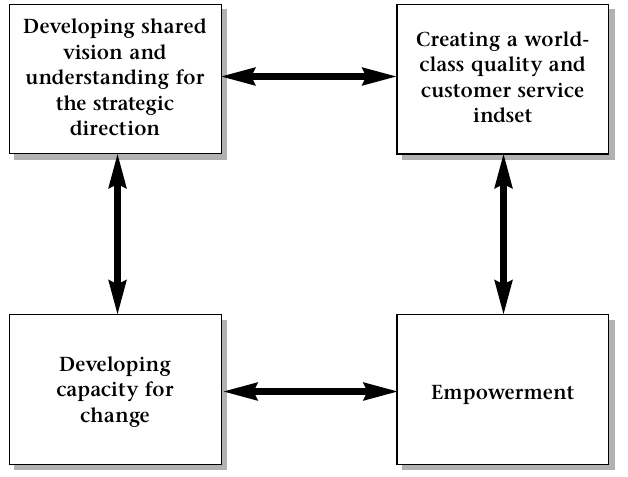
Figure 1: The tasks of leadership in the transition to